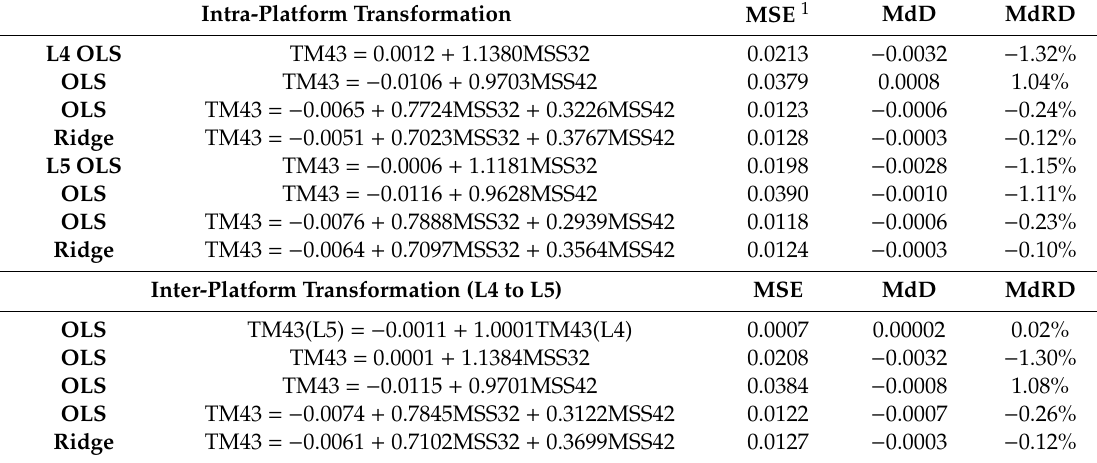
Table 4. Transformation models with median estimates and the associated assessments based on cross-validation